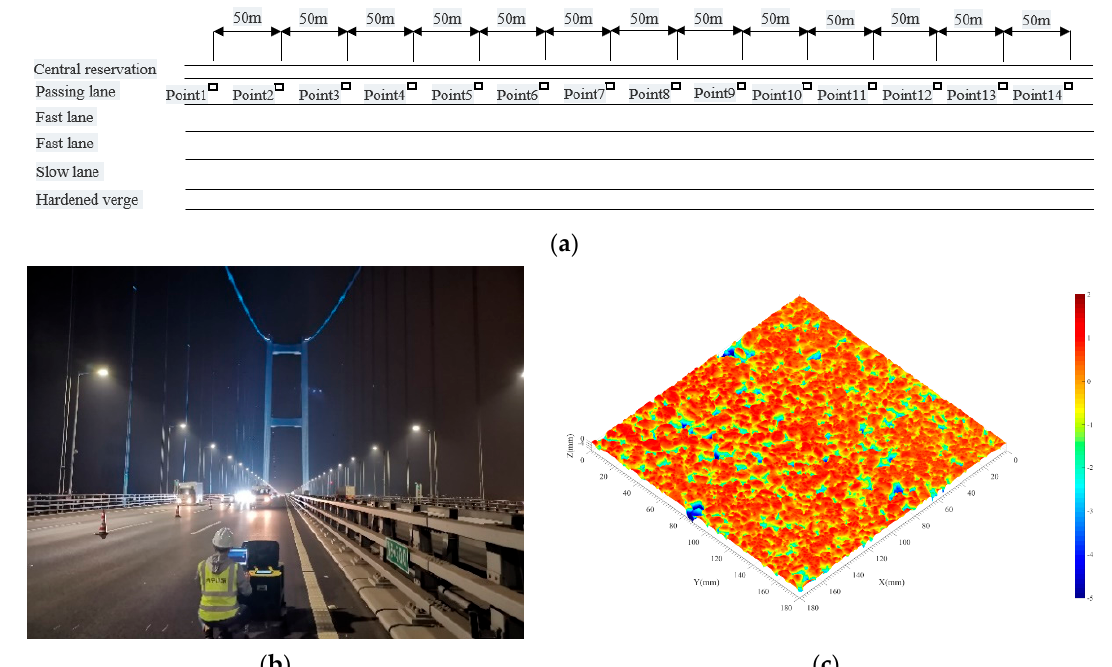
Figure 15. Thre-dimensional structural depth detection: ( a ) detection position; ( b ) field test; ( c ) microscopic cloud map of the road surface.